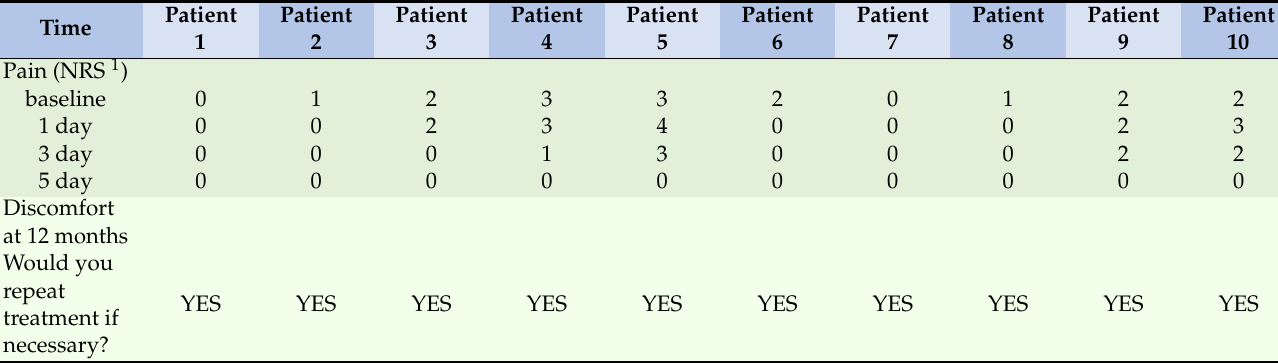
Table 4. Summary of patients’ response